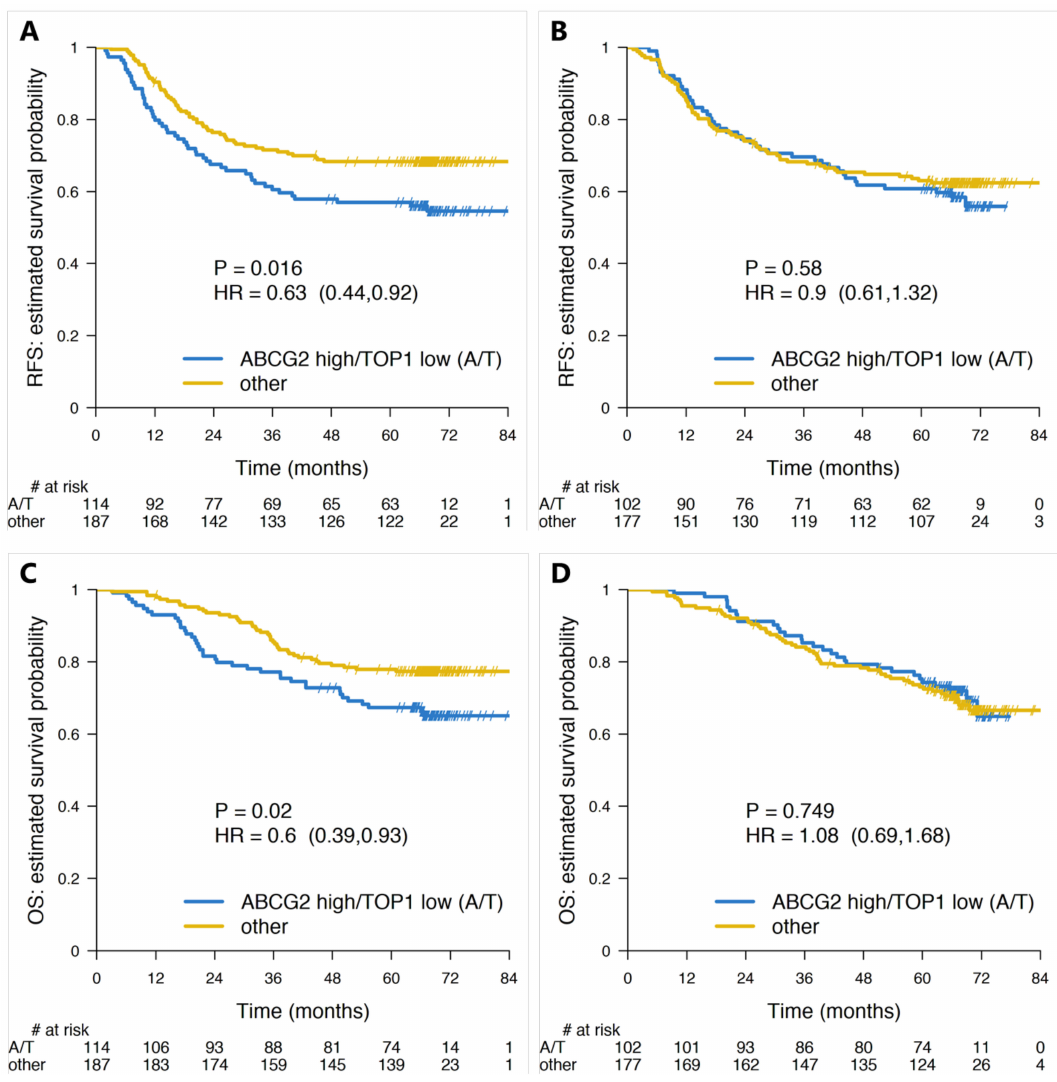
Figure 2. Survival plots (Kaplan-Meier estimates) for “resistant” (ABCG2-high / TOP1-low, abbreviated A / T under the plots) and “sensitive” (all other combinations of ABCG2 and TOP1 genes) patient groups in whole Stage III cohort ( n = 580). The four plots show the RFS of “resistant” (blue line) and “sensitive” (gold line) under ( A ) Fluorouracil / leucovorin (5FUL) + irinotecan (FOLFIRI) and ( B ) 5FUL treatments and the overall survival (OS) of the same groups under ( C ) FOLFIRI and ( D ) 5FUL treatments, respectively. Numbers at risk are given under each